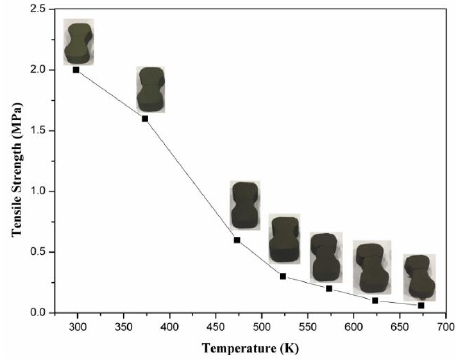
Figure 3. The relationship between sand mold strength and temperature.